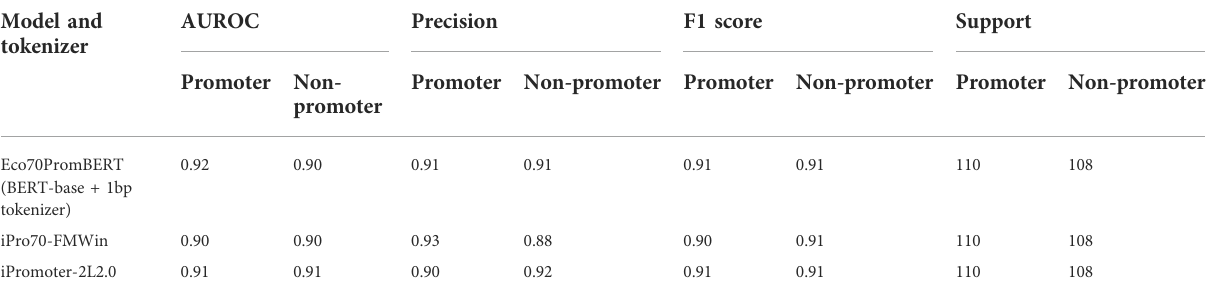
TABLE3PerformanceofEco70PromBERTandpopularpromoterpredictionmodelsfor E.coli using anindependentdataset( σ 70promotersandnon- promoters). Model and